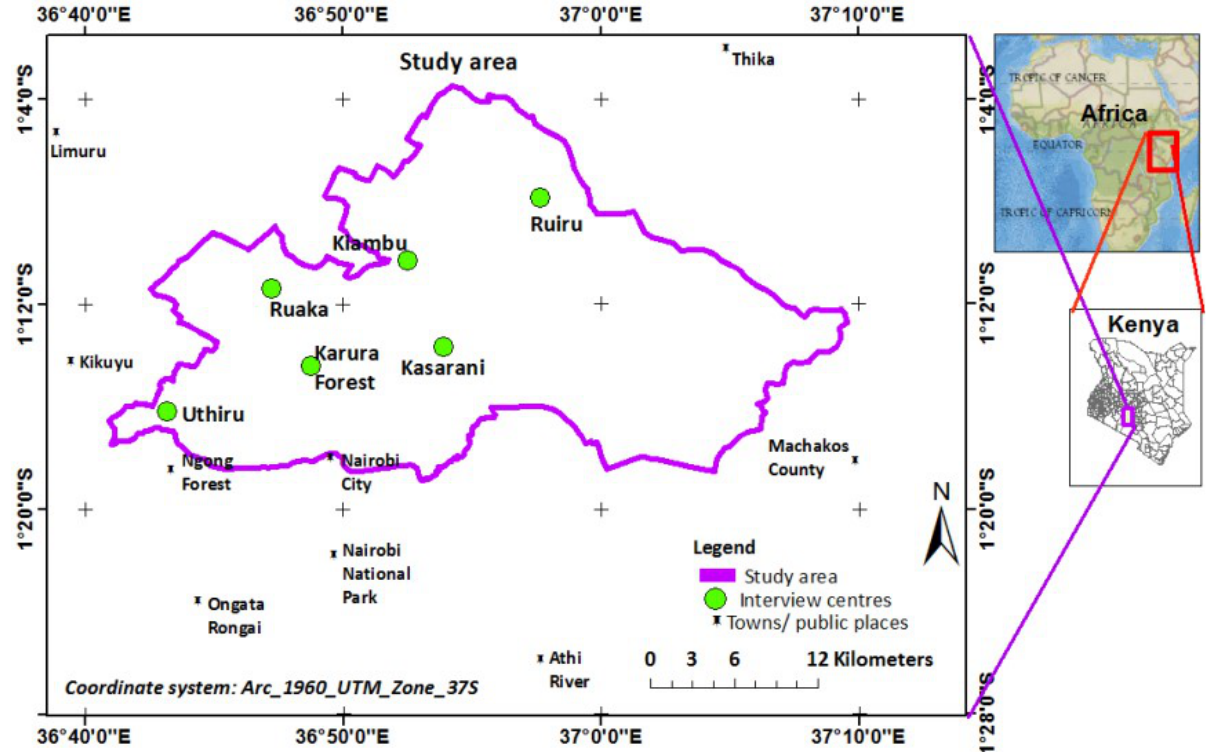
Figure 2: Geographical location of the case study within Nairobi-Kiambu peri-urban